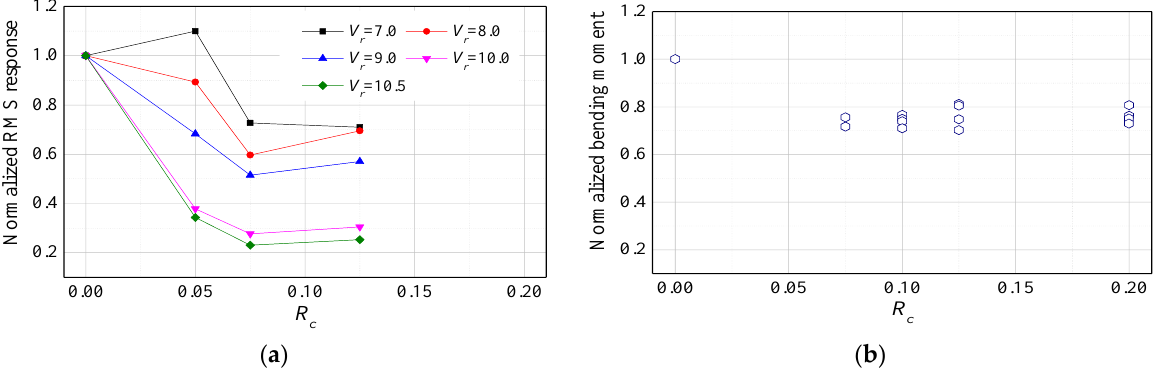
Figure 8. Normalized wind-induced response and bending moment: ( a ) normalized RMS responses; ( b ) normalized bending moment [19].